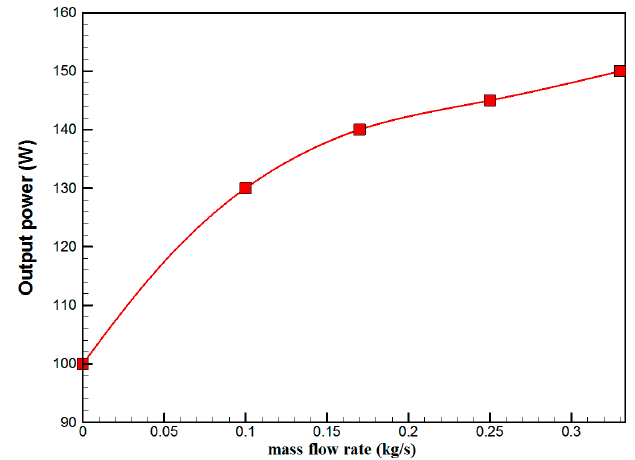
Figure 16. The variation of electrical efficiency with mass flow rate of water for the PVT solar collector with CPC.